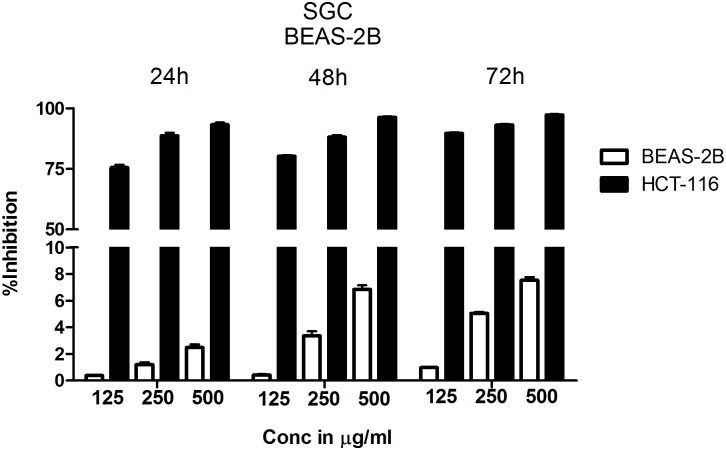
Chloroform extract is selective to colorectal carcinoma cell line HCT-116 compared to normal lung epithelial cell line BEAS-2B. To determine the therapeutic index of chloroform extract, normal lung epithelial cell line BEAS-2B and colorectal carcinoma cell line HCT-116 were treated with increasing concentration of the extract for 24, 48, and 72 h. The number of viable cells determined using SRB and percentage inhibition calculated. Analysis of the data showed a significant difference in the efficacy of chloroform extract with HCT-116 cells more responsive to treatment compared to BEAS-2B, indicating the selectivity of chloroform fraction. The data shown is the Mean ± SEM of three independent experiments with 4 replicate wells in each experiment.